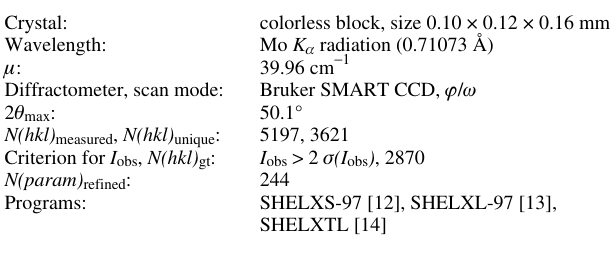
Table 1. Data collection and handling.